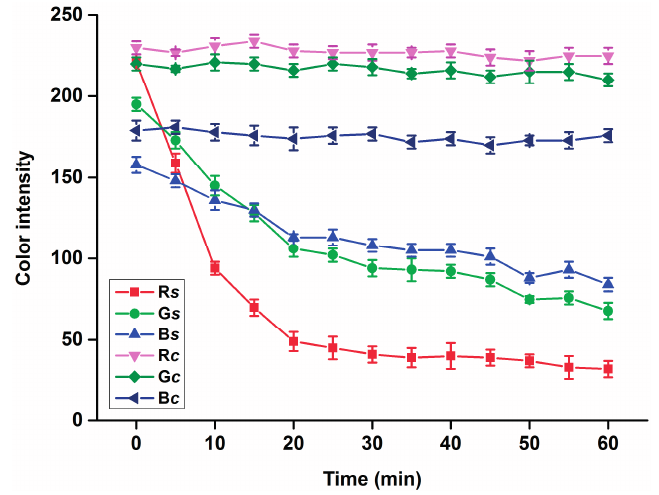
Figure 2. Performance of the smartphone for R, G and B channel color intensity change measurements with time. R s , G s and B s were acquired by assay of plasma samples on filter paper treated with indoxylacetate while R c , G c and B c were determined by assay of plasma samples on papers without any treatment. Error bars indicate standard deviations for n = 5.